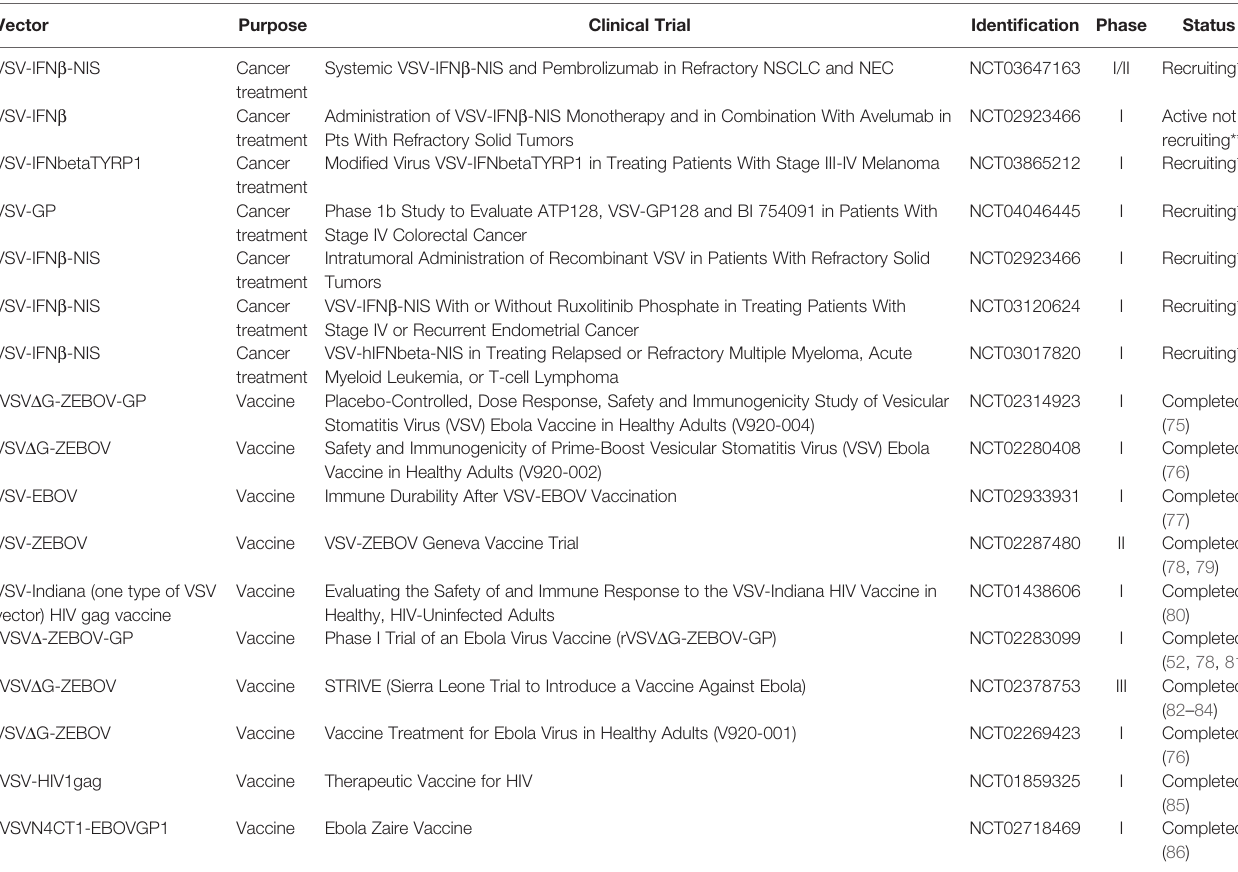
TABLE 1 | Reported VSV-based vaccine and cancer treatment clinical trials (http://clinicaltrial.gov/).